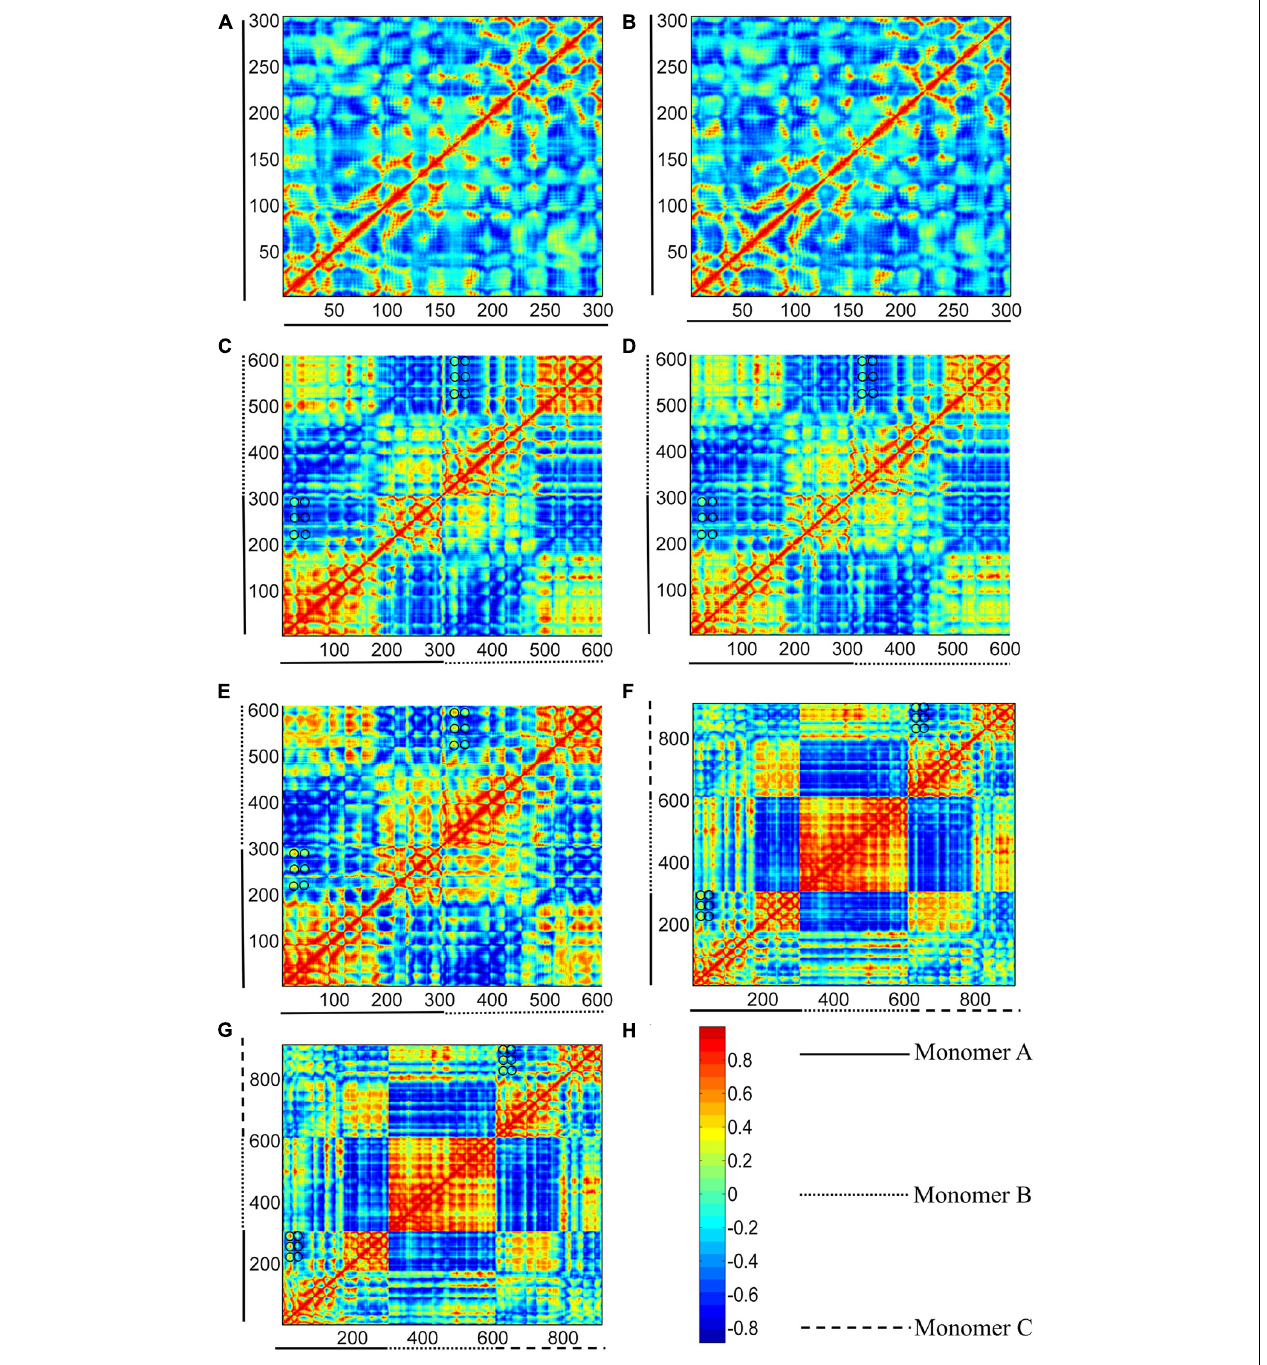
FIGURE 11 | Correlation maps between residue fluctuations calculated from GTP- and GDP-bound structure I (see Figure 1 ). (A,B) subunits in GTP- and GDP-bound structure I, respectively. (C–E) bottom (middle-bottom) and top (top-middle) dimers in GTP-bound structures I, and dimer in GDP-bound structure I. (F,G) trimers for GTP- and GDP-bound structure I. The two axes refer to residue indices. As shown in the color bar (H) , blue and red regions correspond to negatively (opposite-direction) and positively (same-direction) correlated motions, respectively. Important residues were highlight with black circles.